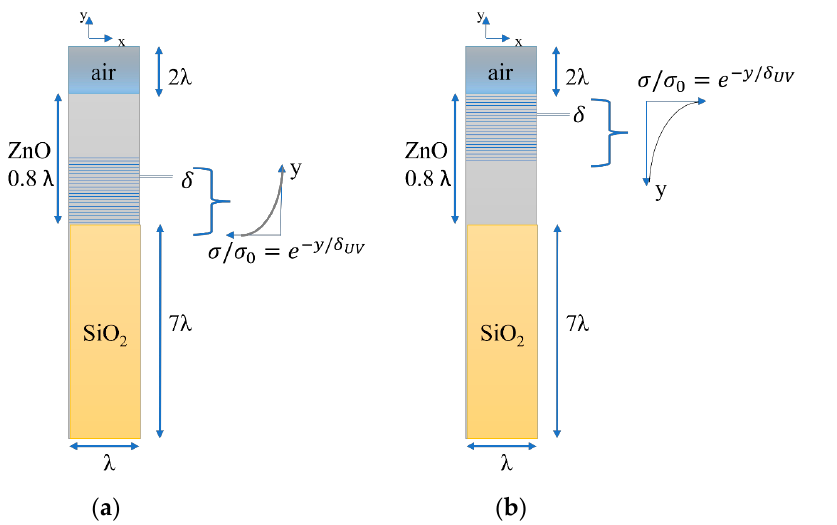
Figure 7. The ZnO/SiO 2 -based unit cell under UV illumination ( a ) from bottom and ( b ) from top. The picture is not in scale.